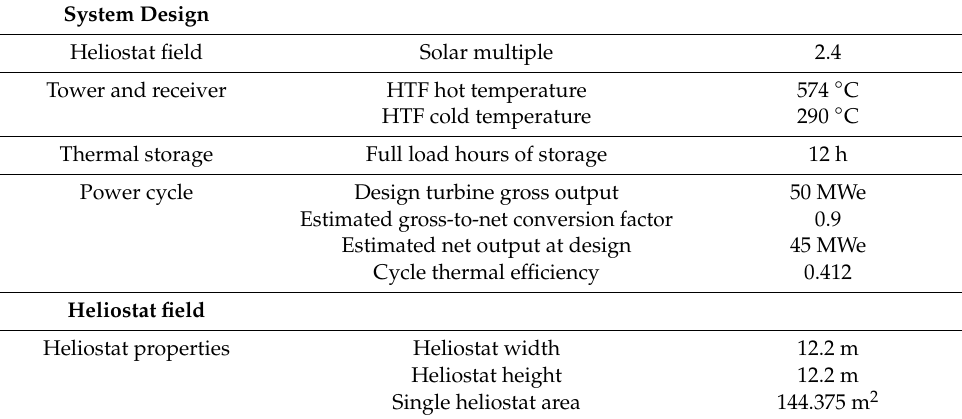
Figure 16. Electricity production by the 50 MWe SPT plant with evaporative cooling for different regions. Table 8. Performance parameters of the 50 MWe SPT plant with evaporative cooling.